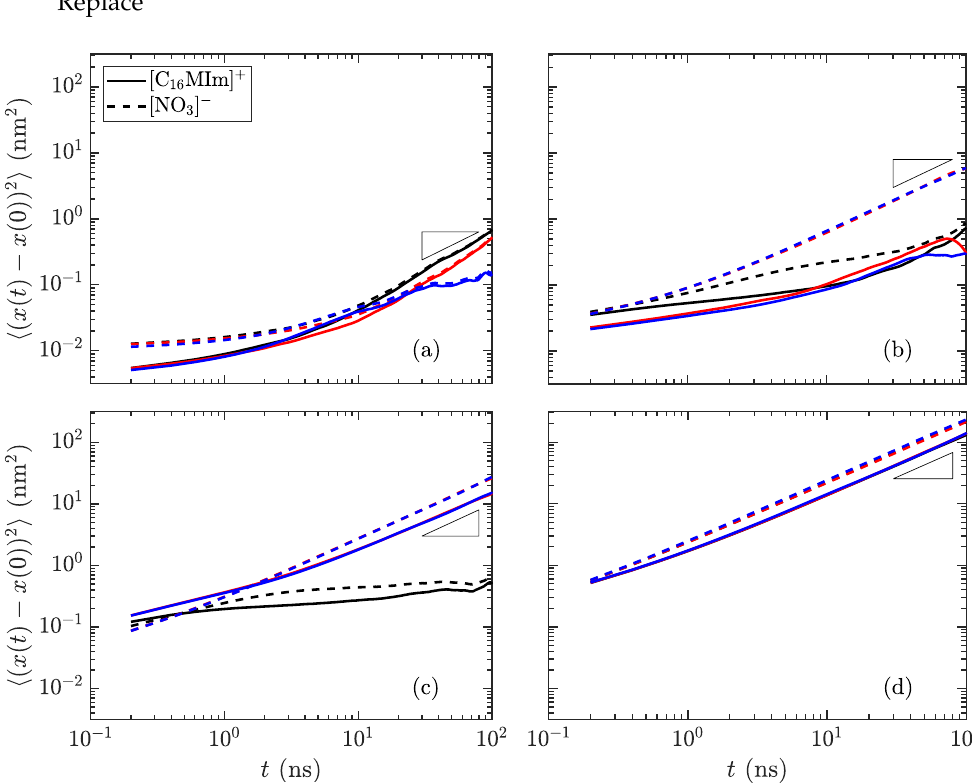
Figure 7. Mean-squared displacement of the species in [C 16 MIm][NO 3 ] as a function of time at temperatures of ( a ) 300K in the crystalline state, ( b ) 400K just before the transition to smectic, ( c ) 425K in the smectic-A phase, and ( d ) 600K isotropic liquid. Reference slopes of 1, indicated as small triangles, help to identify the linear diffusive regime. The colors signify the dimension (red: x , blue: y , black: z ); the solid lines are for the long cations and the dotted lines are for the nitrate anions. The most distinctive difference is the divergence of the z -direction from the x - and y -directions in the smectic-A phase, showing that transport within a layer is much simpler than through the layers. (Notes: ( c ) The x - and y -directions are nearly overlapping. ( d ) All directions nearly collapse, indicating an isotropic